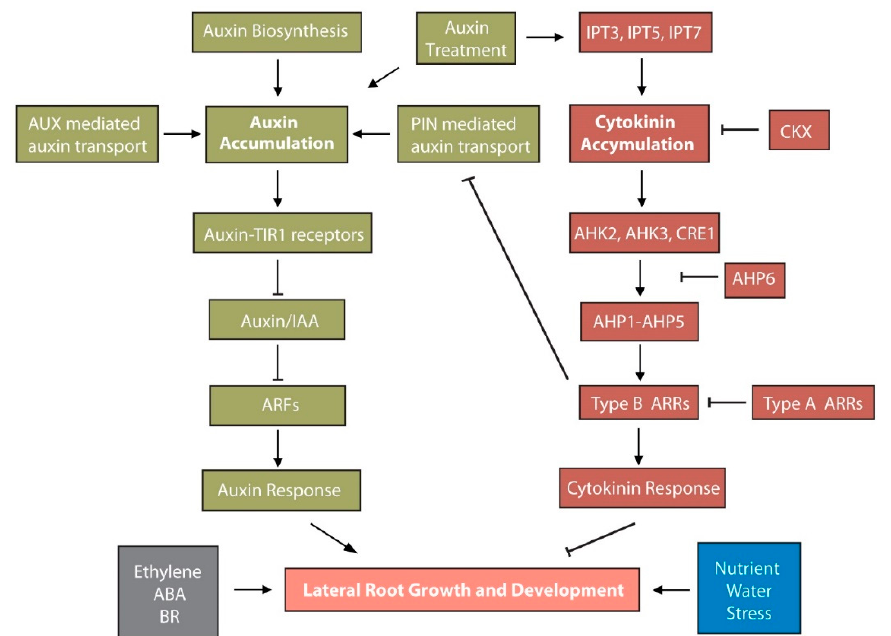
Figure 2. Regulatory interactions between auxin and cytokinin pathways controlling LR development. Auxin acts as a key hormone for LR formation. Components of auxin biosynthesis, transport and signaling including auxin/indole-3-acetic acids (Aux/IAAs) and auxin response factors (ARFs), play important roles in LR initiation and LR primordium development. Cytokinin generally plays an antagonistic role to auxin pathway in LR formation. Cytokinin biosynthesis enzyme IPT, degrading enzyme CKX, and signaling components AHK, ARR, and AHP6, involved in LRs initiation and growth. Arrows and inhibition lines represent positive and negative interactions, respectively. ABA, abscisic acid; AHK, Arabidopsis histidine kinase; AHP, Arabidopsis histidine phosphotransferase; ARR, arabidopsis response regulator; AUX, auxin resistant; Aux/IAA, Auxin/indole-3-acetic acid; ARF, auxin response factor; BR, brassinosteroid; CKX, cytokinin oxidase; CRE1, cytokinin response 1; IPT, isopentenyl transferase; PIN, PIN-formed; TIR1, transport inhibitor response 1.